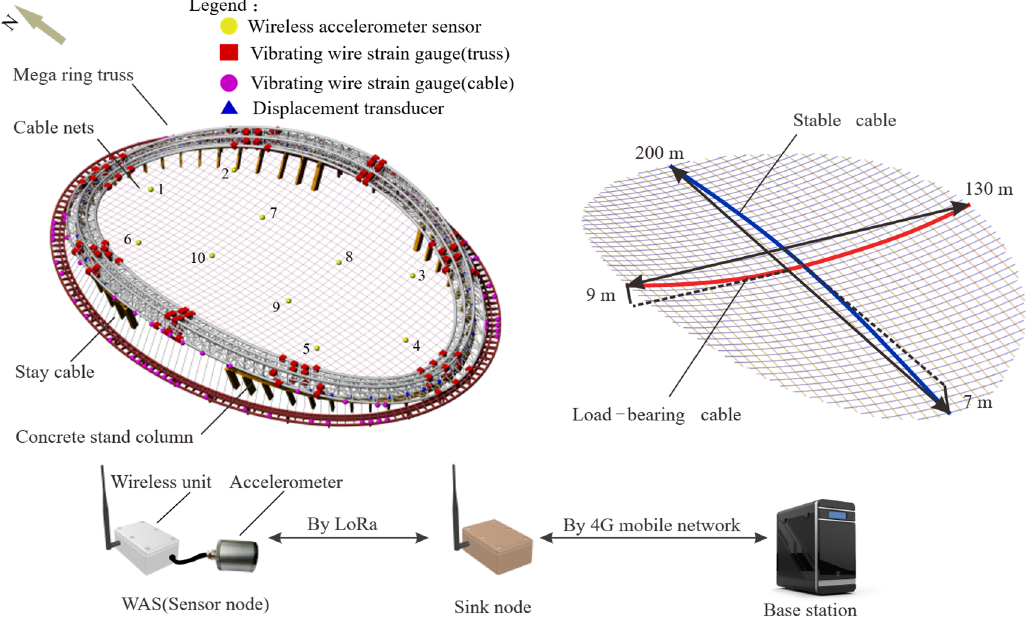
Figure 15. Layout of the sensors and monitoring procedure based on